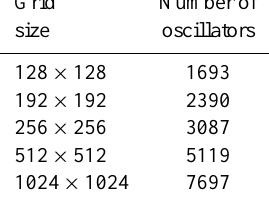
Table 1. Grid sizes and the number of oscillators corresponding to non-zero cells. Grid Number of size oscillators 128 × 128